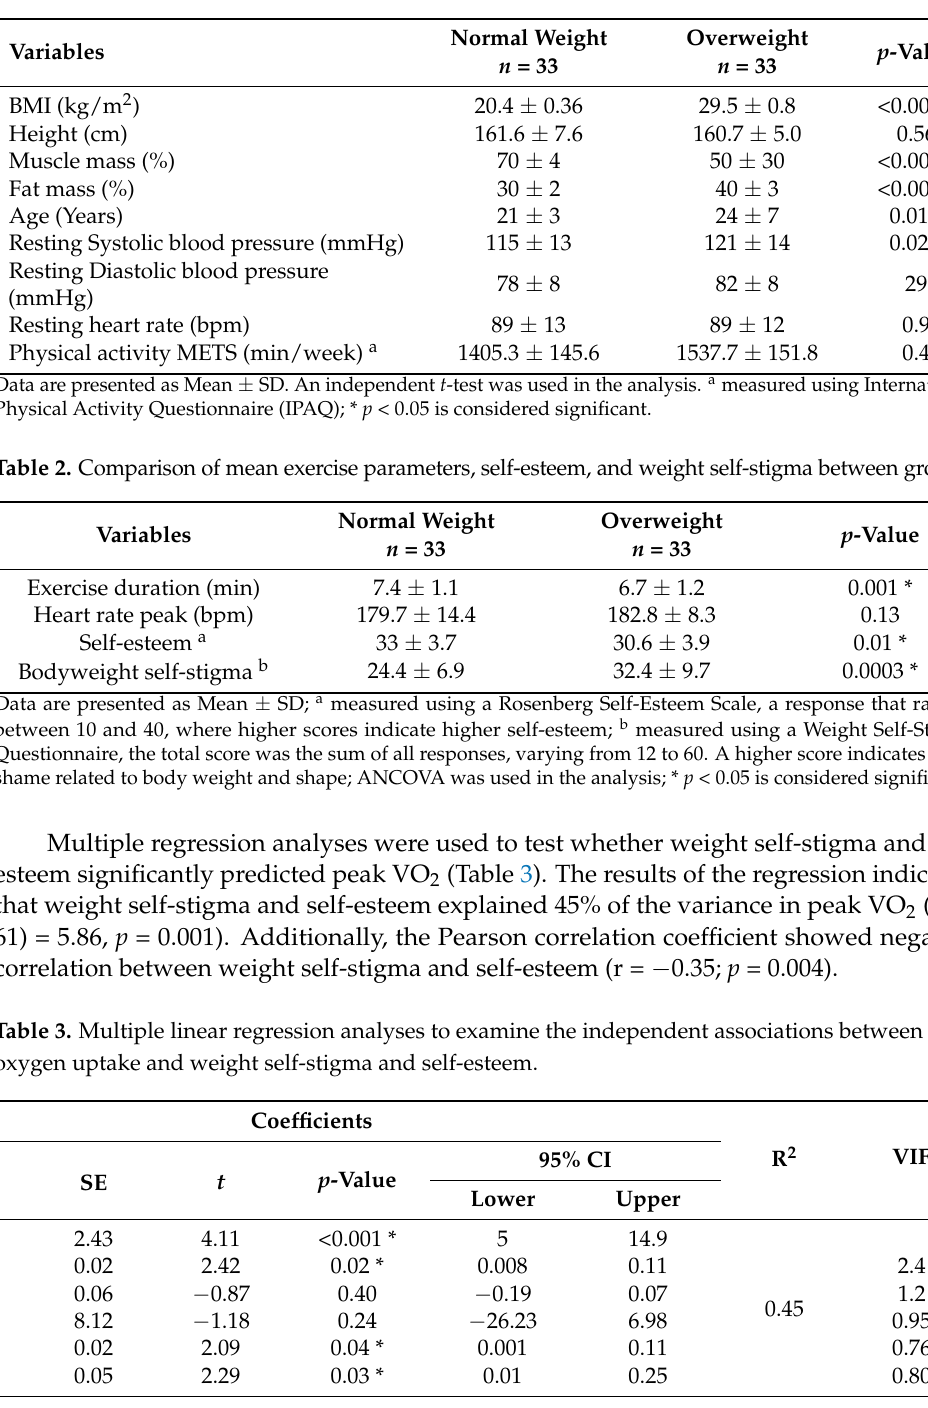
Table 1. Baseline characteristics of the participants in the study.